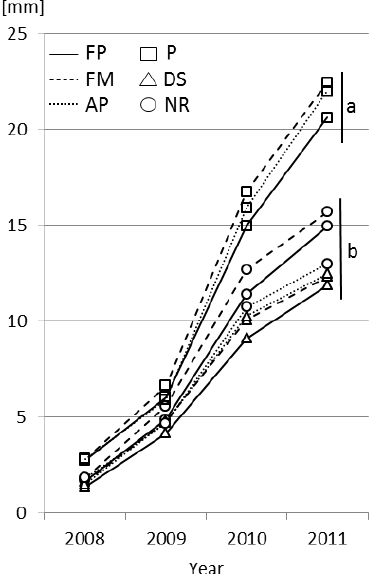
Figure 3. Mean root collar diameter (mm) of Scots pine seedlings in 4 years for three reforestation methods (planting (P); direct seeding (DS); natural regeneration (NR)) and three mechanical site preparation methods (forest plough (FP); forest mill (FM); active plough (AP)). Different letters indicate significant differences in the Tukey HSD test, p ≤ 0.05. Table 2. Average density (seedlings ha − 1 , coefficient of variation in brackets) of Scots pine seedlings (excluding self-sown seedlings that germinated in the second year) in 4 years for three reforestation methods (planting, direct seeding, natural regeneration) and three mechanical site preparation methods (forest plough (FP); forest mill (FM); active plough (AP)). Treatment Planting FP